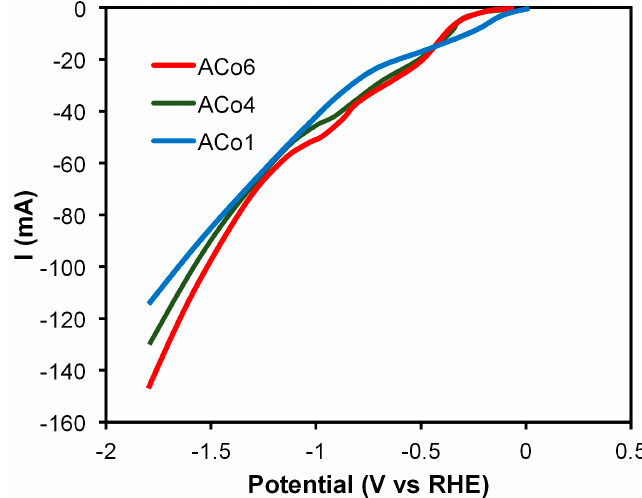
Figure 8. Linear sweep voltammetries obtained from the equilibrium electrode potential to a negative electric potential of − 1.79 V vs. RHE. Scan rate: 5 mV/s. Fresh electrodes ACo6, ACo4, and ACo1 in CO 2 ‐ saturated 0.1 M KHCO 3 .